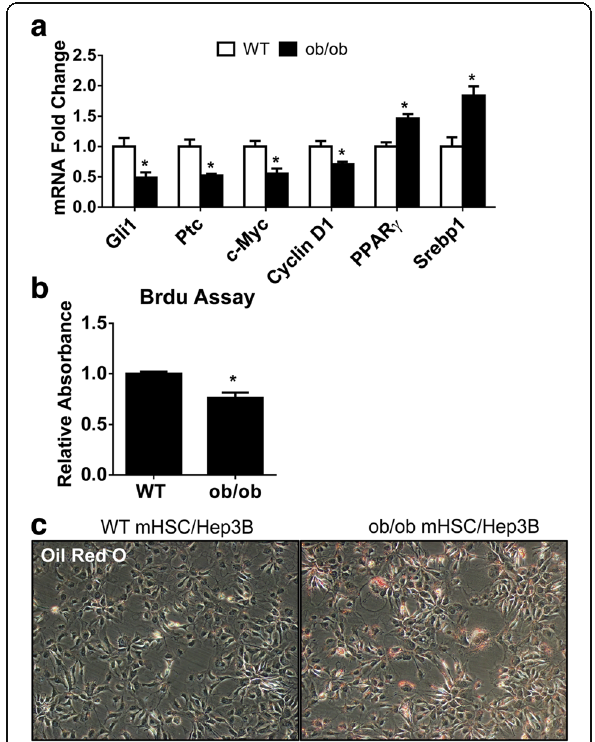
Fig. 4 Leptin Deficient HSCs Alter Hepatocyte Phenotype. Primary HSCs isolated from WT or ob/ob mice were cultured alone in Transwell inserts for 4 days. Hep3B cells grown on plastic dishes were then co-cultured with either WT or ob/ob HSC for 3 additional days. a qRT-PCR analysis of Hh target genes (Gli1 and Ptc), proliferation genes (c-Myc and Cyclin D1) and lipid associated genes (PPAR γ and Srebp1) in Hep3B cells after co-culture with either WT or ob/ob HSC. b BrdU assay of proliferation in Hep3B cells co-cultured with either WT or ob/ob HSC. c Oil Red O staining was used measure lipid content in Hep3B co-cultured with either WT or ob/ob HSC. (original magnification, ×10). * p <0.05 vs Hep3B co-cultured with WT